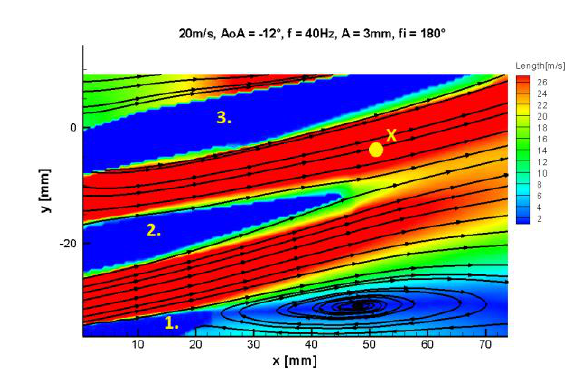
Fig. 4a, b. PIV measurement of compressor and turbine cascade, velocity distribution, vector lines, X-point location.